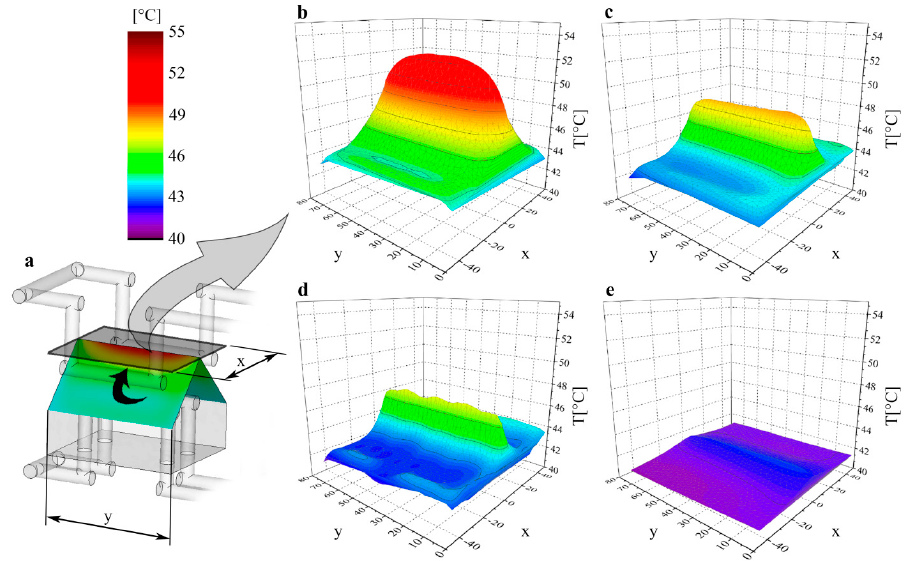
Figure 5. ( a ) Temperature distribution transformed into one plane in the case of the ( b ) P20 , ( c ) Multi-part , ( d ) DMLS , and ( e ) Ampcoloy mold inserts.